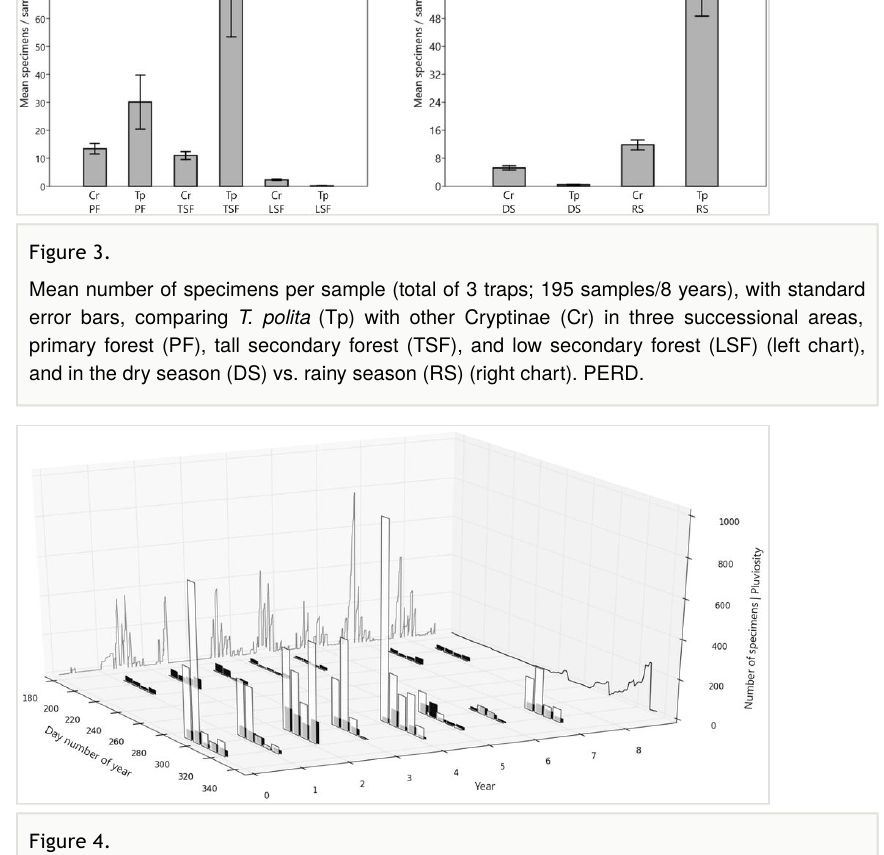
For Cryptinae as a whole, sampling e ffi ciency during the RS was 0.56, versus 0.25 in the DS, that is, 2.25× higher in the rainy season. The increase matches the observations of Kumagai (2002) for the Ichneumonidae in a preserved area in the Atlantic Forest, which tripled in number in the traps in the RS. This indicates that a two to threefold increase during the rainy season could be “normal” for Ichneumonidae as a whole. For T. polita , however, seasonal in fl uence was higher by two orders of magnitude, with sampling e ffi ciency rising from 0.02 in the DS to 2.92 in the RS – a 146× increase (Table 2).